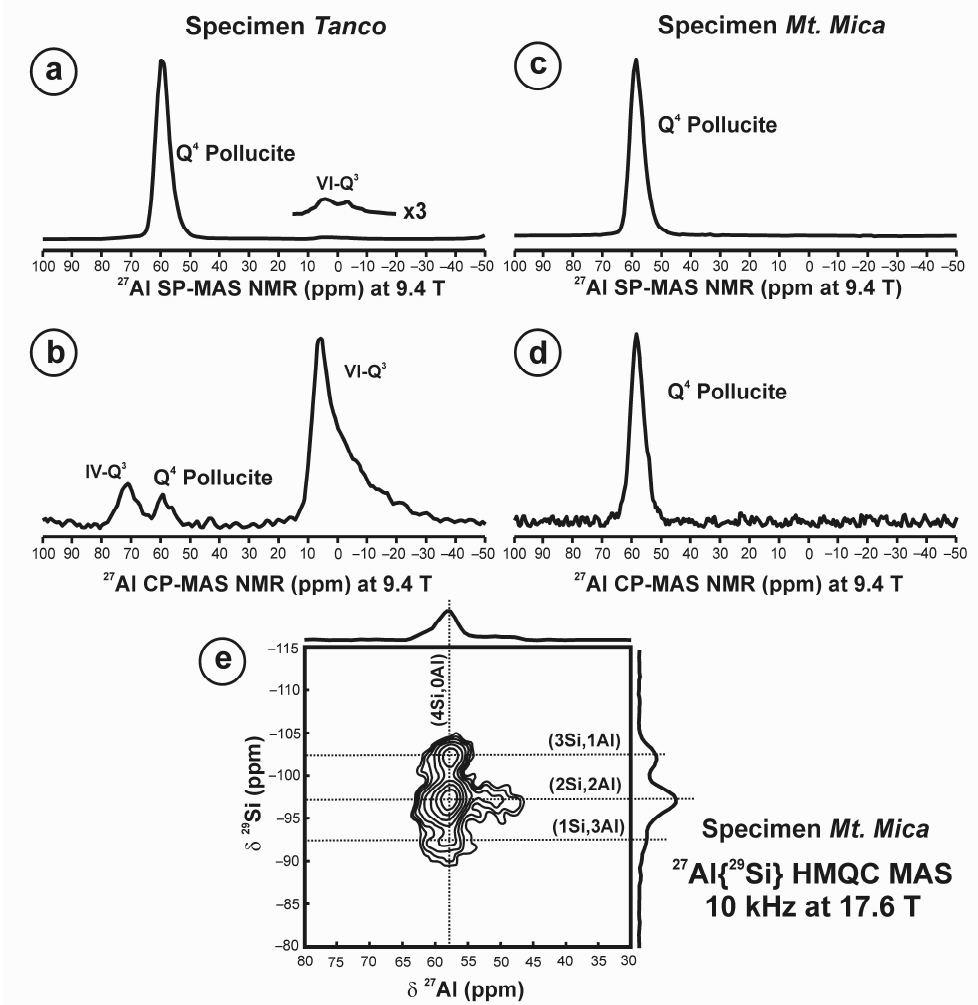
Figure 5. The 27 Al MAS NMR spectra of the two pollucite specimens: ( a , b ) single pulse SP-MAS and CP-MAS spectra of specimen Tanco at 9.4 T; ( c , d ) single pulse SP-MAS and CP-MAS spectra of specimen Mt. Mica at 9.4 T; ( e ) 27 Al{ 29 Si } HMQC spectrum at 10 kHz and 17.6 T of specimen Mt. Mica . The 27 Al CP-MAS experiments have been done at 8 ms of contact time. Table 6. NMR parameter of the 27 Al spectra at 9.4 T of two specimens of pollucite. Specimen Tanco